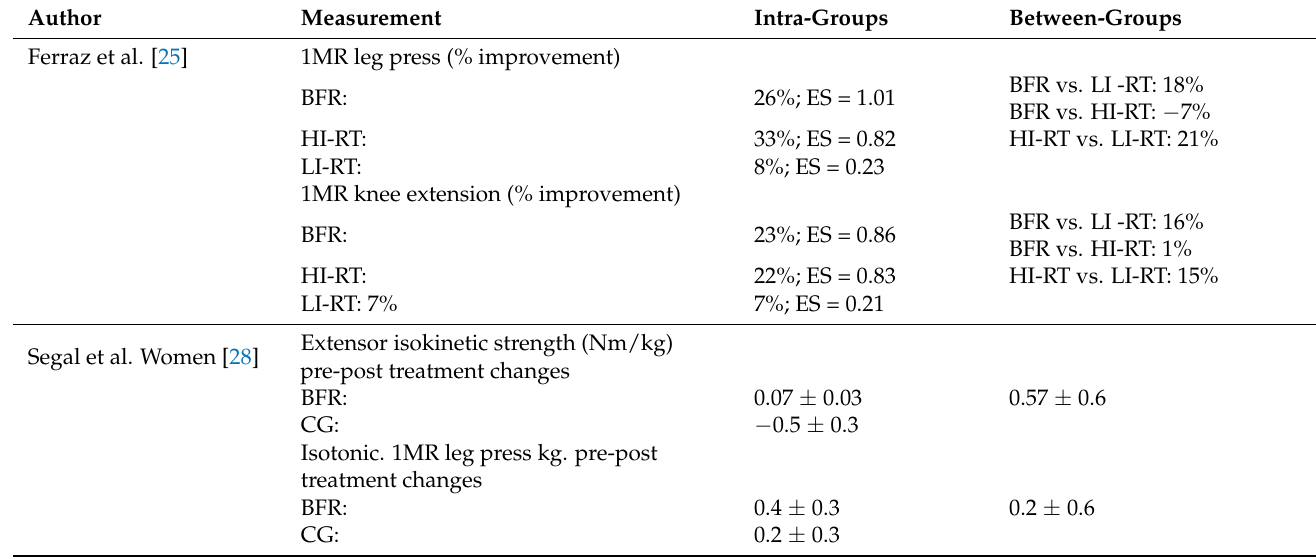
Table 2. Strength